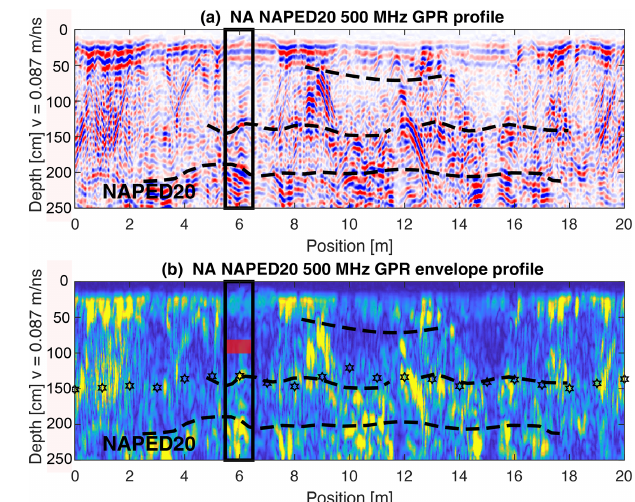
Figure 15. 500MHz GPR signal and envelope for the mid-slope position of the S-facing hillslope in Nahuelbuta (NAPED20). The hillslope transect spans over ∼ 20m. Interpretation of the radar sig- nal is indicated where possible (stippled lines in a and b ). The po- tential pedolith thickness is indicated based on the envelope profile. Uphill is from left to right. Lines and symbols in figures as described in Fig.